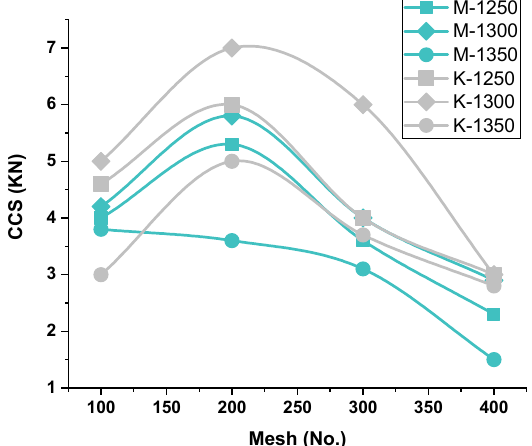
Figure 3. Effect of (Mesh no.) fineness on C.C.S.(KN/pellet)of iron ore No.1/No.2 pellets.